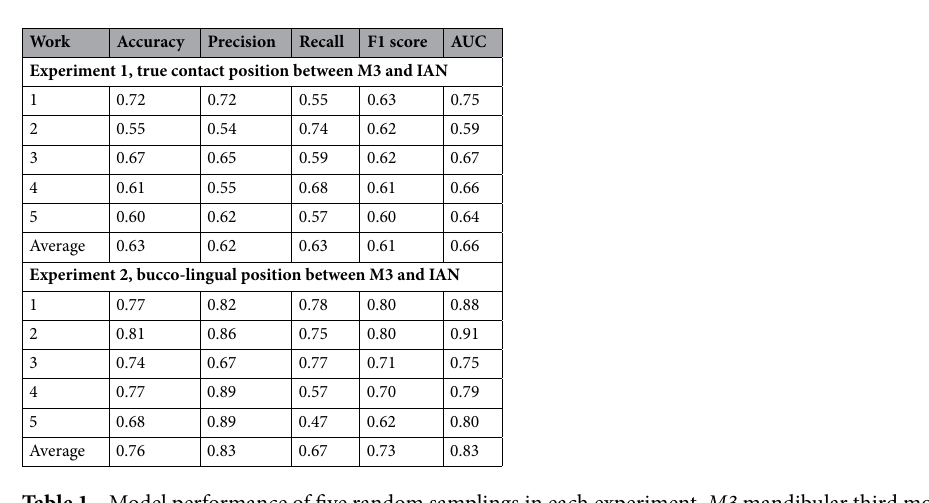
Table 1. Model performance of five random samplings in each experiment. M3 mandibular third molar, IAN inferior alveolar nerve, AUC Area under the ROC curve.